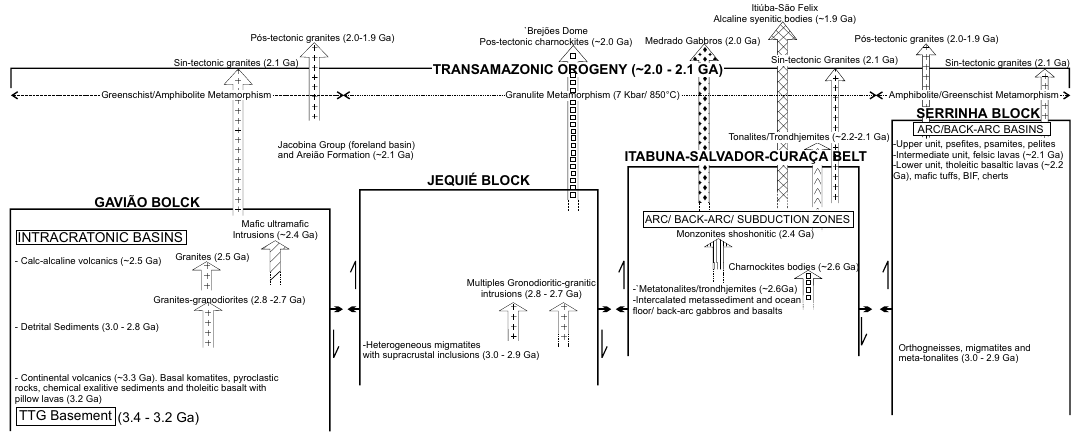
ciado aos processos colisionais está datado em cerca de 2.0